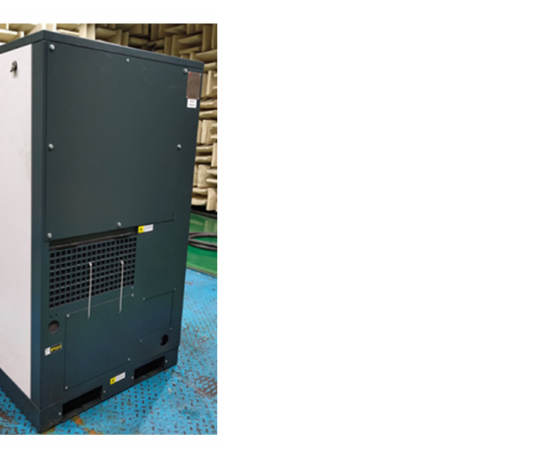
Figure 4. Schematic diagram of monitoring points.